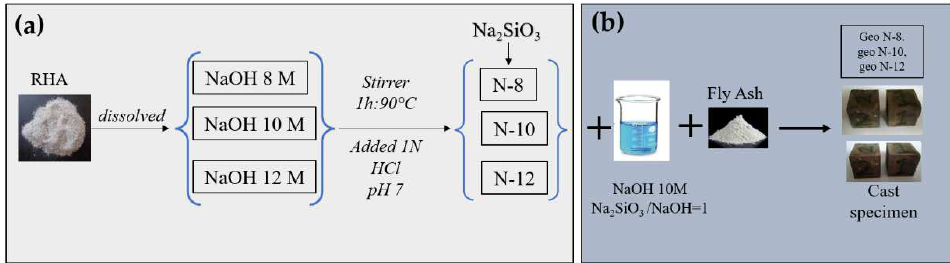
Figure 2. Geopolymer production process, ( a ) synthesis of sodium silicate, and ( b ) preparation of geopolymer paste.